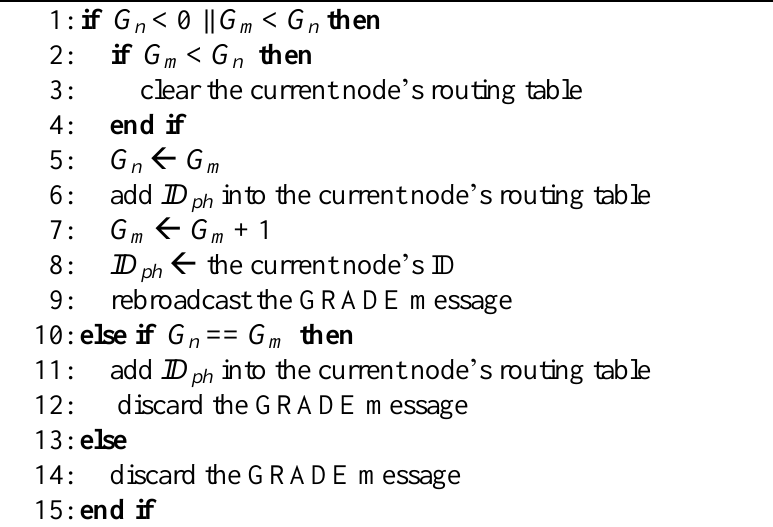
Algorithm 2. The modified GDSA : processing the received GRADE message.